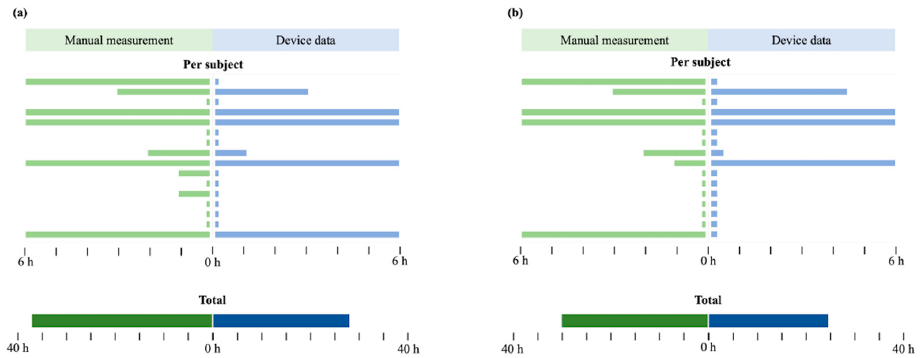
Figure 4 . Prediction timepoint data for all patients with positive outcomes. ( a ) Fragmented model. ( b ) Accumulated model.